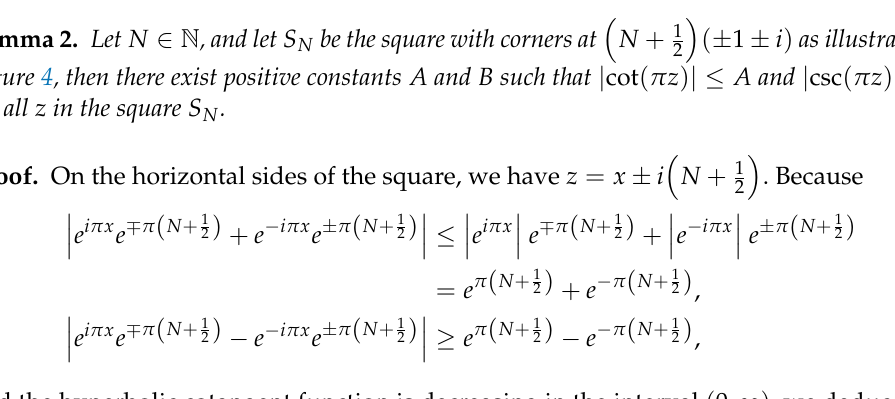
Figure 3: The poles of sech also shows the several circles C